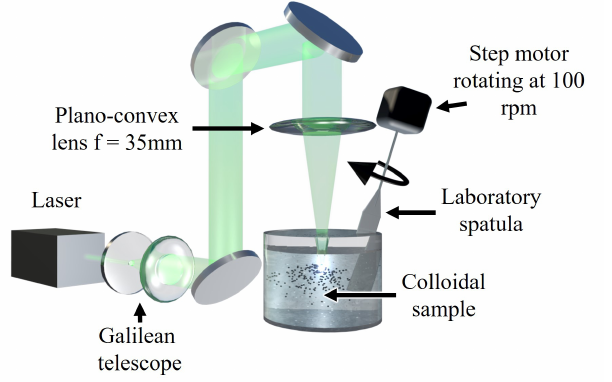
Figure 1. Experimental setup used for the synthesis of Fe ultra-small NPs by the photothermal vaporization of carbonyl iron